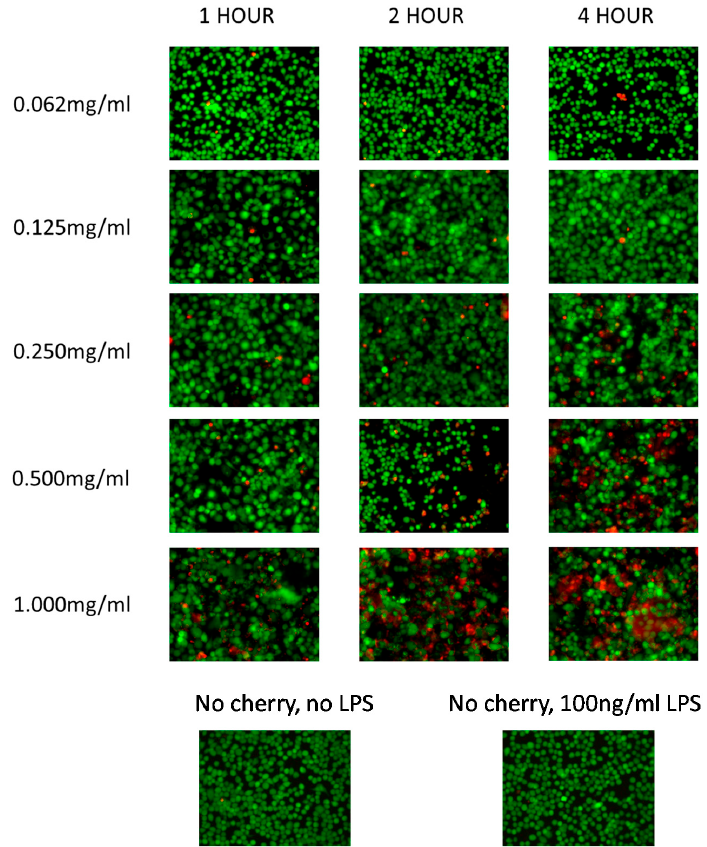
Figure A1. Effect of tart cherry powder on cellular viability. Representative images of cells treated with tart cherry powder (0.062, 0.125, 0.250, 0.500, or 1.000 mg/mL) for 1, 2, or 4 h, as well as cells treated with 0 cherry and 0 or 100 ng/mL LPS. Live cells with intact membranes are labeled green with Calcein AM, while dead cells with damaged membranes are labeled red with ethidium homodimer-1. Images were taken under a fluorescent microscope at 80× magnification.